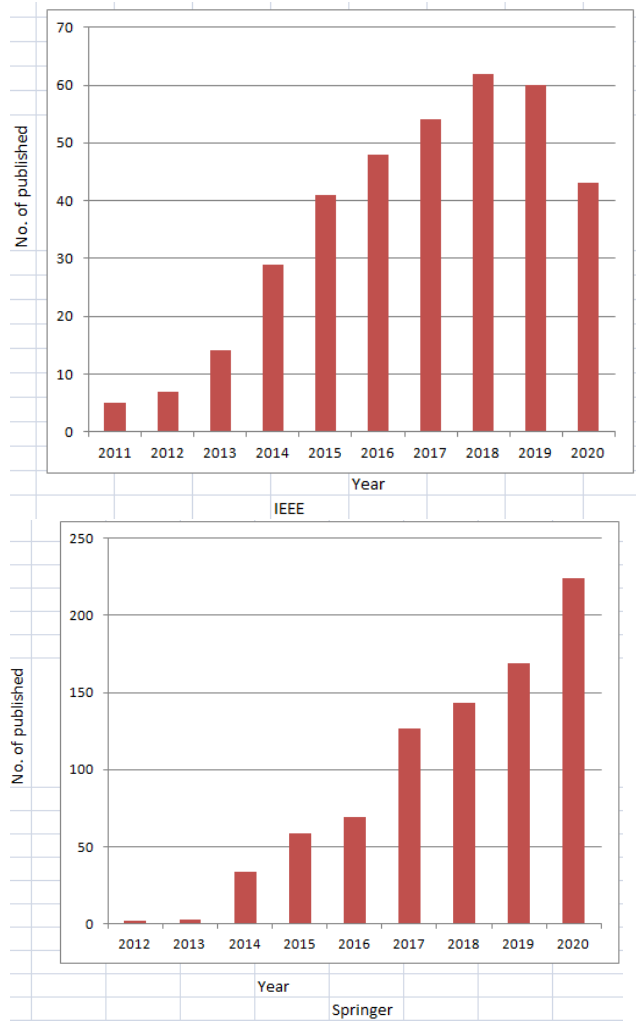
Figure 3. Research trend for resource allocation and power control techniques in